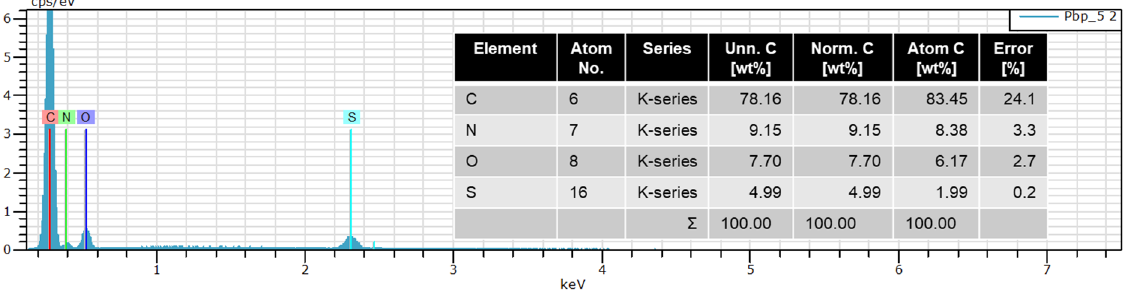
Figure 3. EDX analysis of S ‐ 2.5A/B.